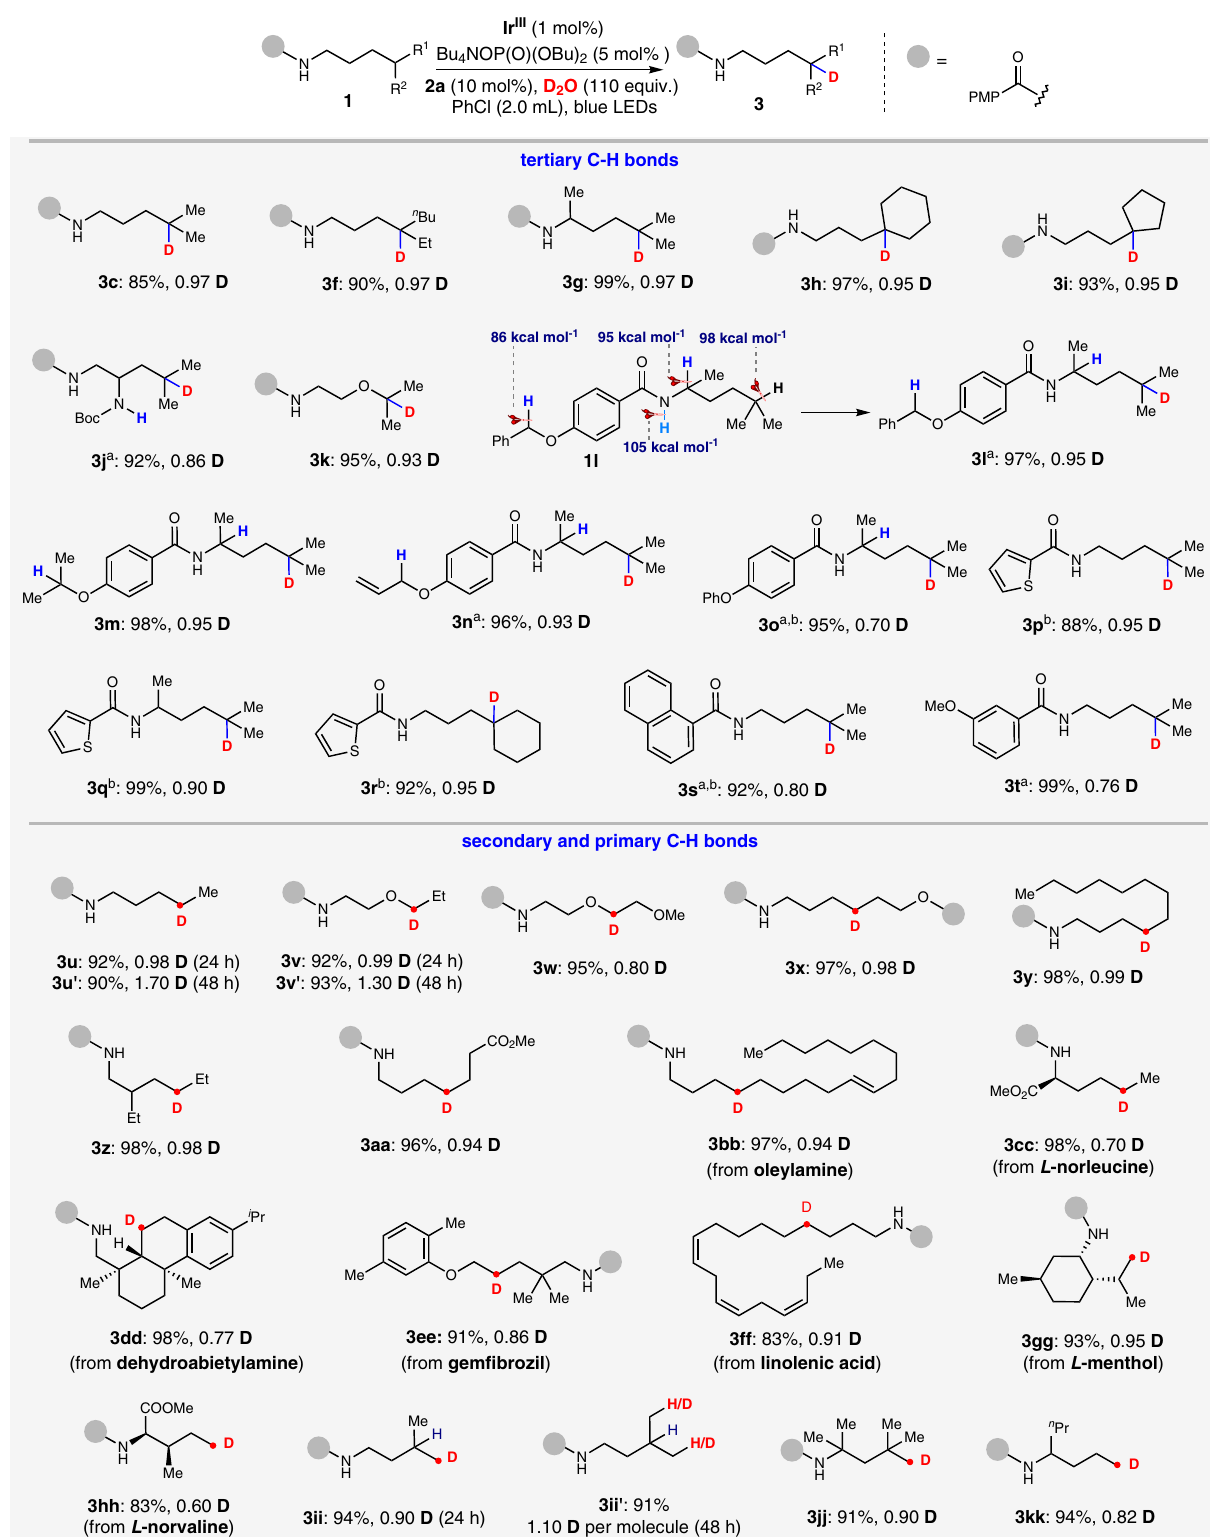
Fig. 2 Scope of the radical H/D exchange of C(sp 3 )-H bonds. Reaction conditions: Ir III (1 mol%), Bu 4 NOP(O)(OBu) 2 (5 mol%), 2a (10 mol%), amide 1 shown and the deuterium incorporation ratio was determined by 1 H NMR spectroscopy. PMP = 4-methoxyphenyl. a 48 h. b 2c (10 mol%) instead of 2a